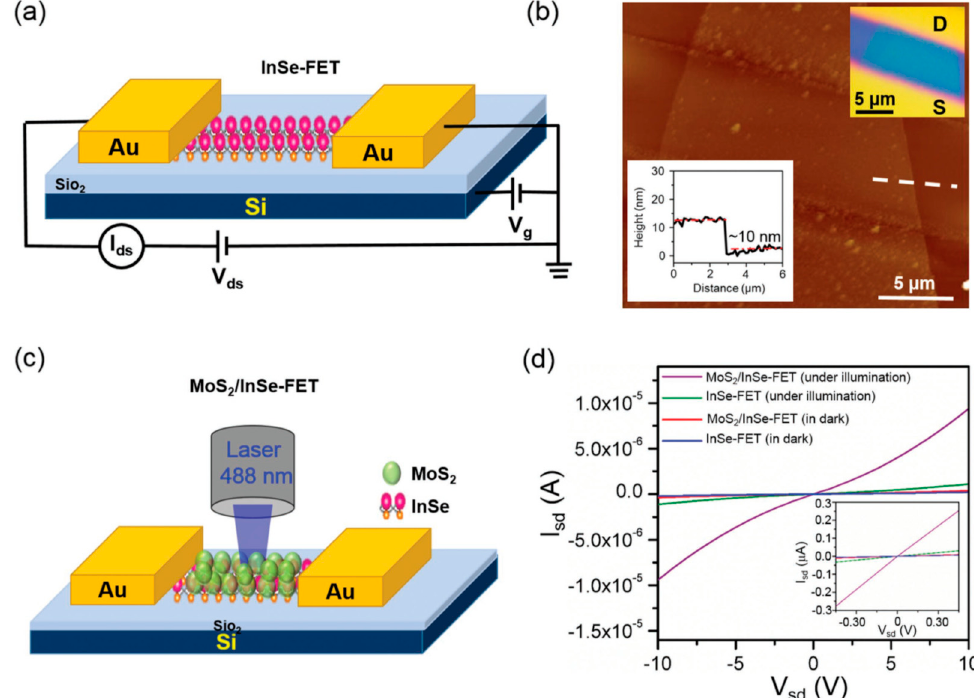
Figure 18. ( a ) Schematic illustration of the InSe-FET device. ( b ) AFM image of the conducting channel of an InSe-FET device. Inset shows the thickness of the InSe nanosheets. ( c ) Schematic illustration of a hybrid MoS 2 /InSe-FET device under photoresponsive measurements. ( d ) The I SD -V SD curve of the InSe-FET and MoS 2 /InSe-FET devices in both dark and illuminative states. Inset demonstrates good contact between the InSe channel and electrodes. Reproduced with permission from [94]. WILEY-VCH Verlag GmbH & Co. KGaA, Weinheim, 2019.